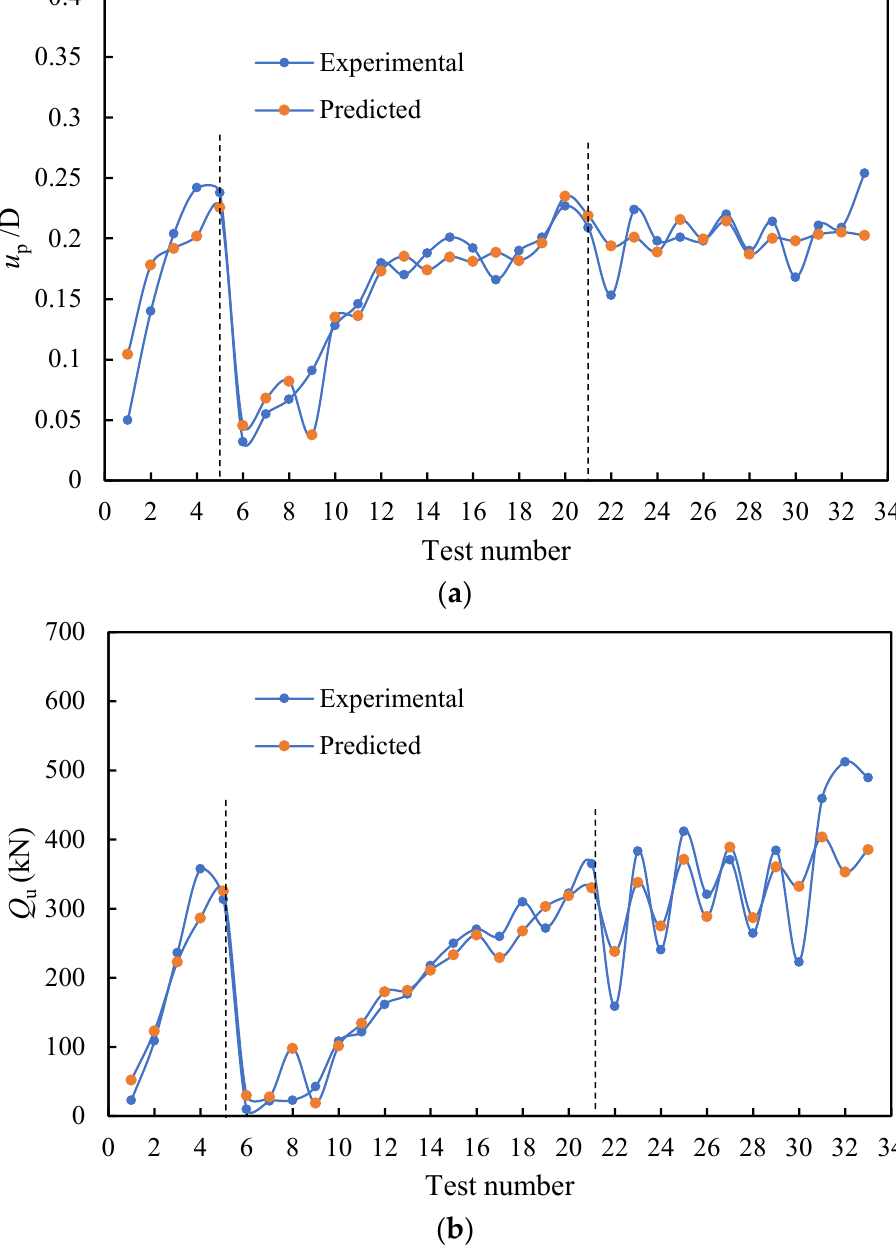
Figure 8. Performance of the optimal GBDT model on the experimental and predicted value: ( a ) evaluation of experimental and predicted u p ; ( b ) evaluation of experimental and predicted Q u . To further verify the model results, the cumulative frequency of the predicted values within a specific error range was repeatedly calculated (30 times) using the a20-index and P30, with the results shown in Figure 9. Specifically, for u p , the mean values of the a20-index and P30 were 0.724 and 0.819, respectively; the equivalent values for Q u were 0.70 and 0.824. All these results are close to 1, indicating good generalization performance of the